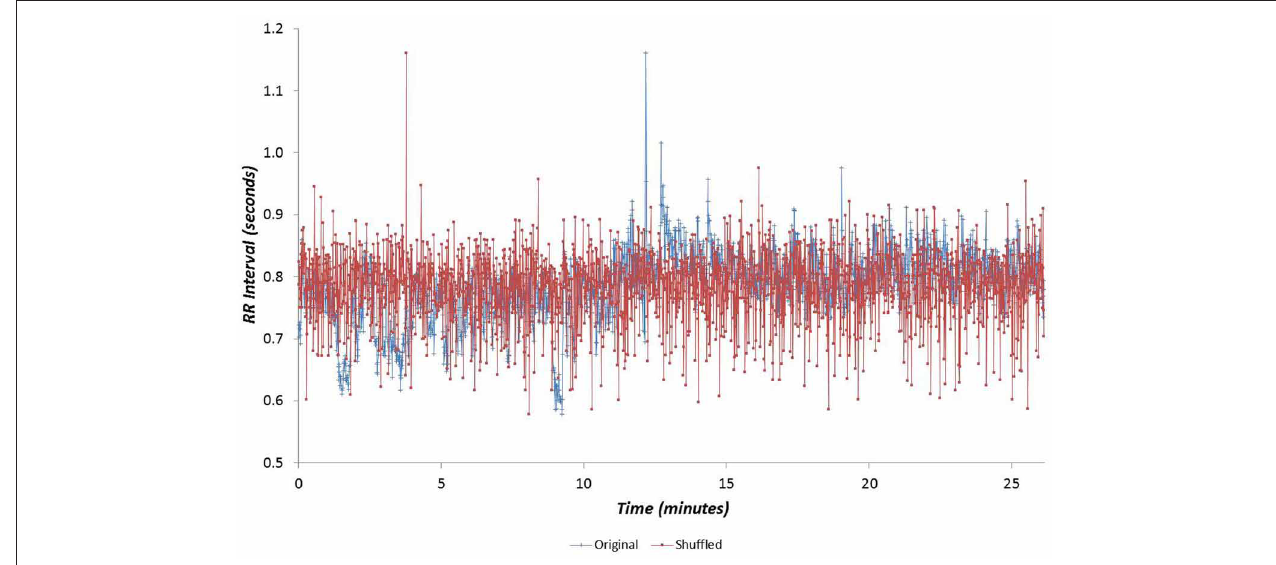
FIGURE 1 | Example cardiac interval (RR) time-series for the Morning period, shown with the same data following data shuffling.